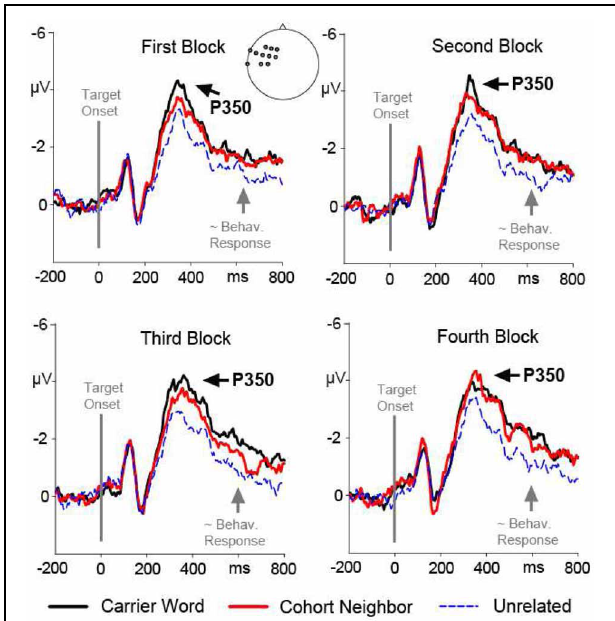
FIGURE 4 | Target-locked ERP waveforms over the left anterior ROI (P350 effect) elicited by the first, second, third and fourth presentation (block) for each target word. Brain responses to the carrier word condition (e.g., ano-Anorak) are given in solid black lines, to the cohort neighbor condition (ana-Anorak) in solid red lines, and to the unrelated condition (e.g., paste-Anorak) in dashed blue lines. The target word onset is indicated by a vertical line. The approximate behavioral response for the slowest condition (partial overlap) is marked by an